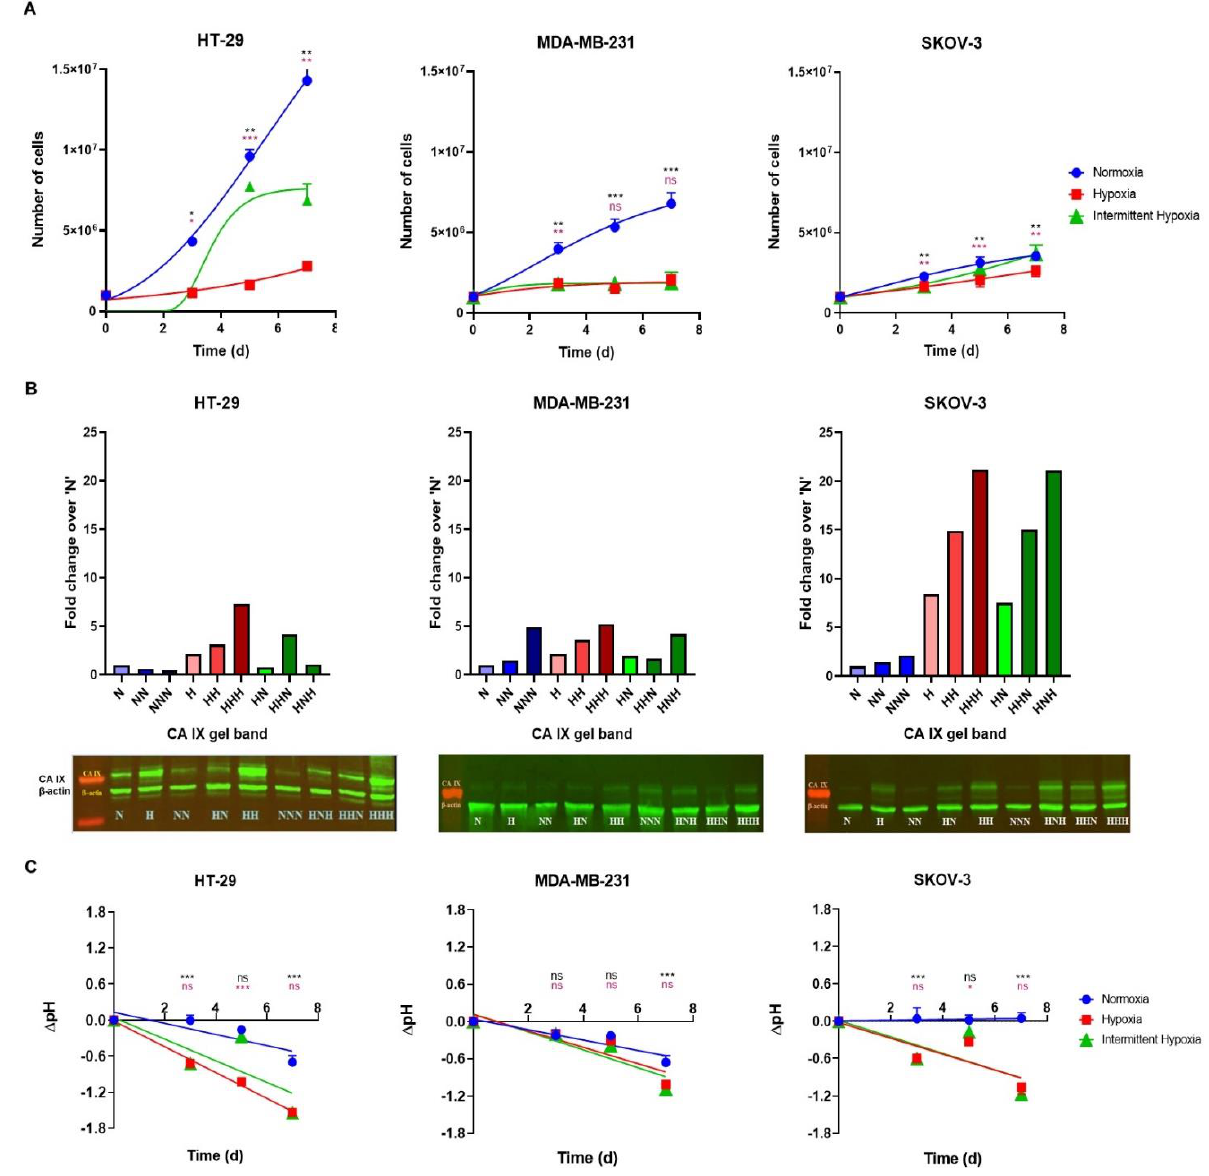
Figure 3. Cell growth dynamic ( A ), CA IX expression ( B ), with Western blot on the bottom and CA IX band signal integration on top) and extracellular pH drop in growth media ( C ) under normoxia (N, NN, NNN), hypoxia (H, HH, HHH) and intermittent hypoxia (HN, HNH and HHN) in HT-29, MDA-MB-231 and SKOV-3 cells. p -values were determined by one-way ANOVA. * p < 0.05, ** p < 0.01, *** p < 0.001 and ns = not significant. Black and pink stars indicate statistically significant difference in intermittent hypoxic and hypoxic groups respectively as compared to normoxic group. In SKOV-3 cell line, the CA IX was completely retained, while HT-29 and MDA-MB- 231 cell lines had larger fluctuations of the epitope level. Interestingly, when SKOV-3 and MDA-MB-231 cells exposed to intermittent hypoxia re-experienced hypoxic conditions (HNH), the CA IX expression level increased further, reaching the expression level of the